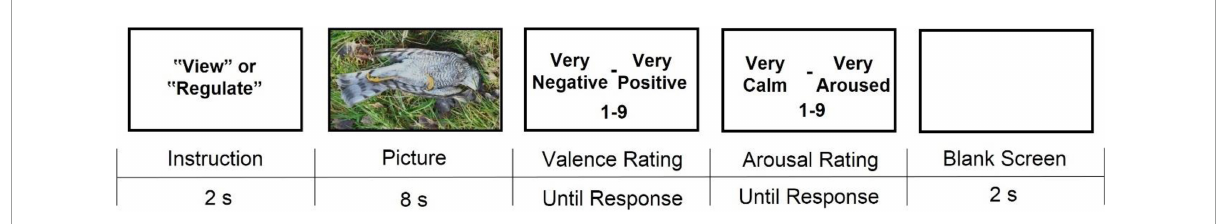
FIGURE2 Timeline of a trial in the affect reactivity and regulation task. Valence and arousal ratings were accompanied by Self-Assessment Manikins (SAM; Bradley and Lang, 1994). The picture presented in this figure is shown for illustrative purposes only.